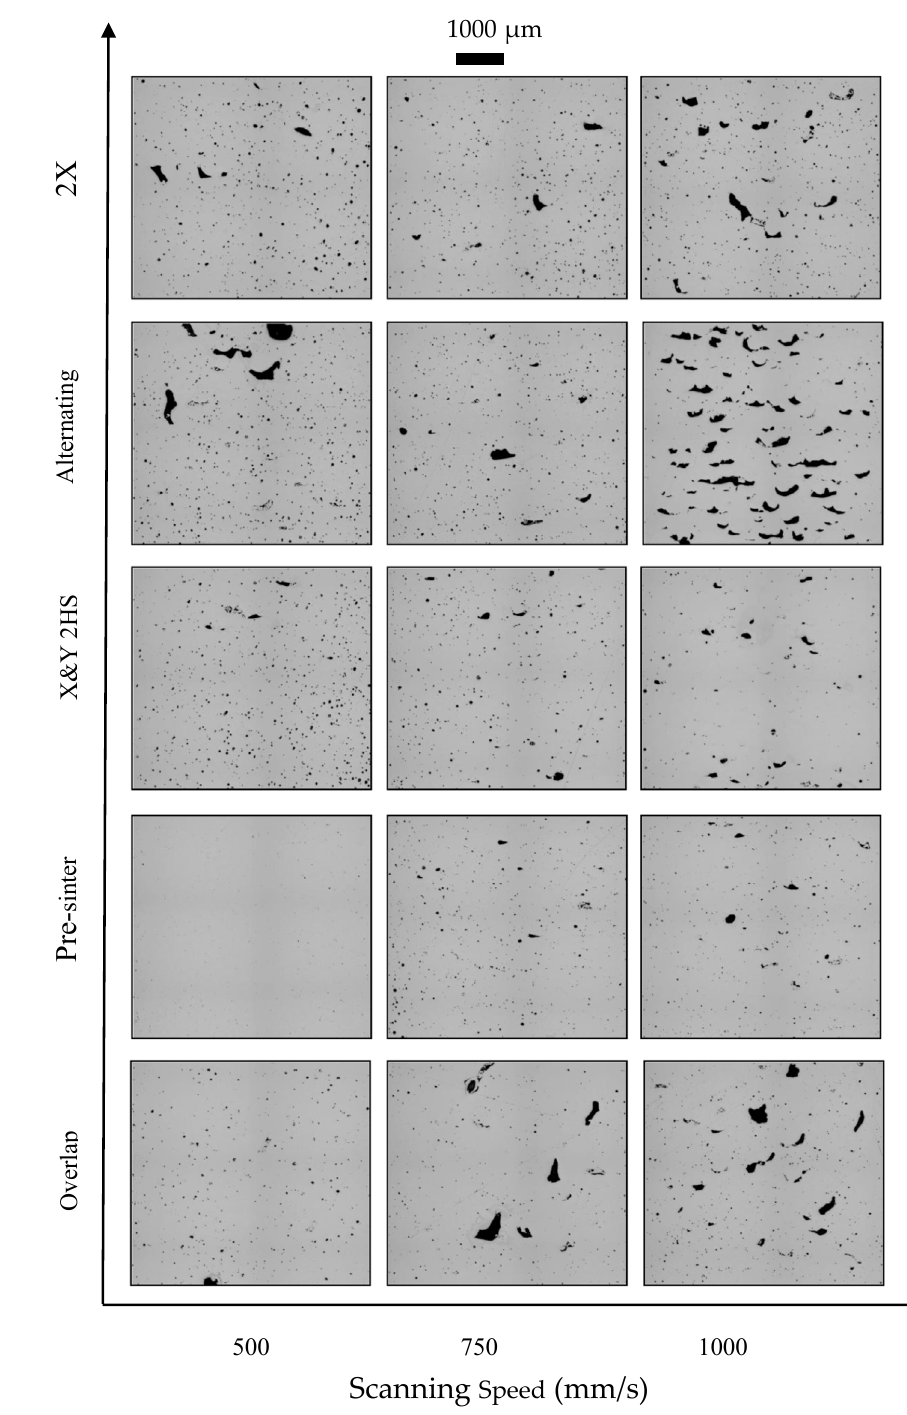
Figure 7. Effect of scanning strategies and scan speed on the porosity % of AlSi10Mg parts [30]. Reused under Creative Commons Attribution License.